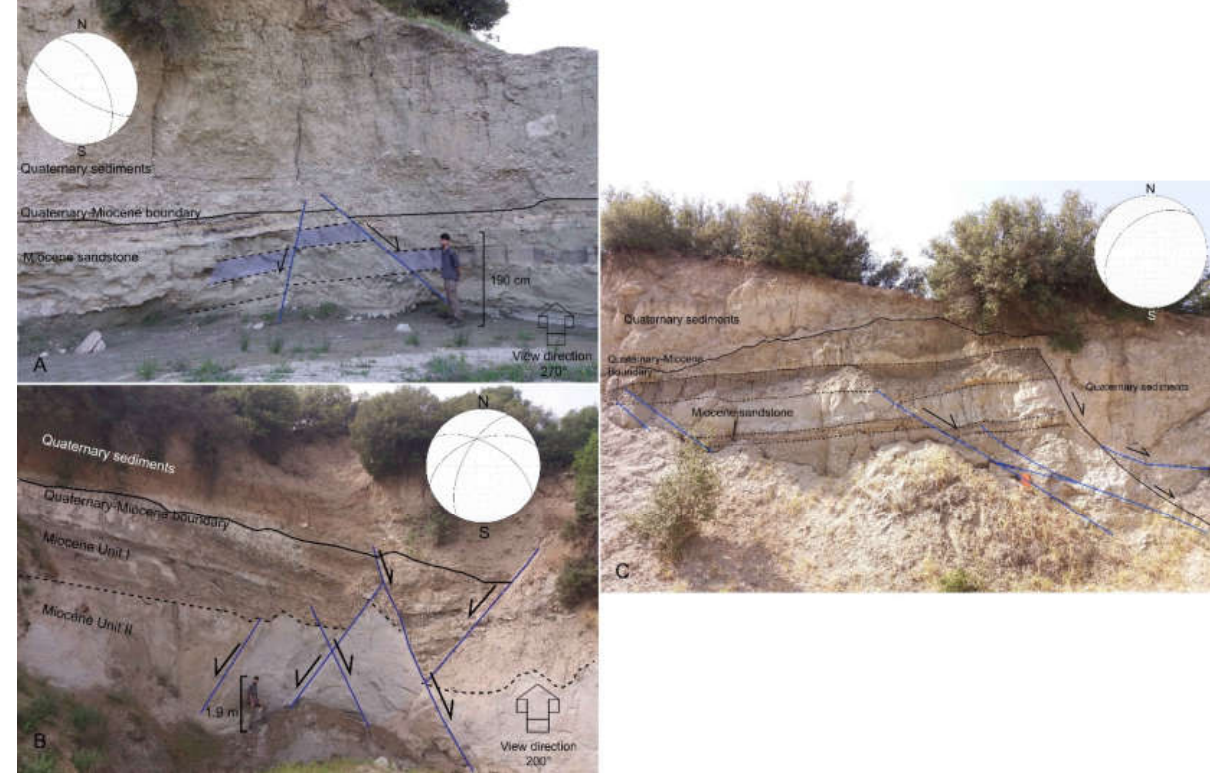
Figure 8. Field photographs showing two examples of extension-related normal faulting ( A ) 652190-4285123, 435 m, ( B ) 653864-4280877, 475 m, and listric faulting ( C ) 653217-4281021, 459 m. The fault propagation extends through different rock units in each photograph. UTM Zone 35 coordinate system is used.